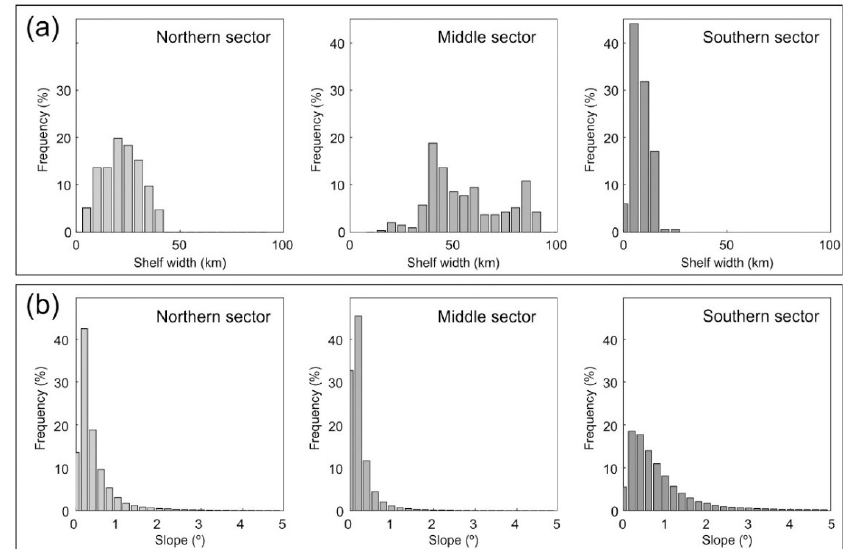
Figure 4 . Frequency distribution of main geomorphological parameters of the continental shelf measured every 2 km along the Mediterranean continental margin: ( a ) shelf width and ( b ) slope.